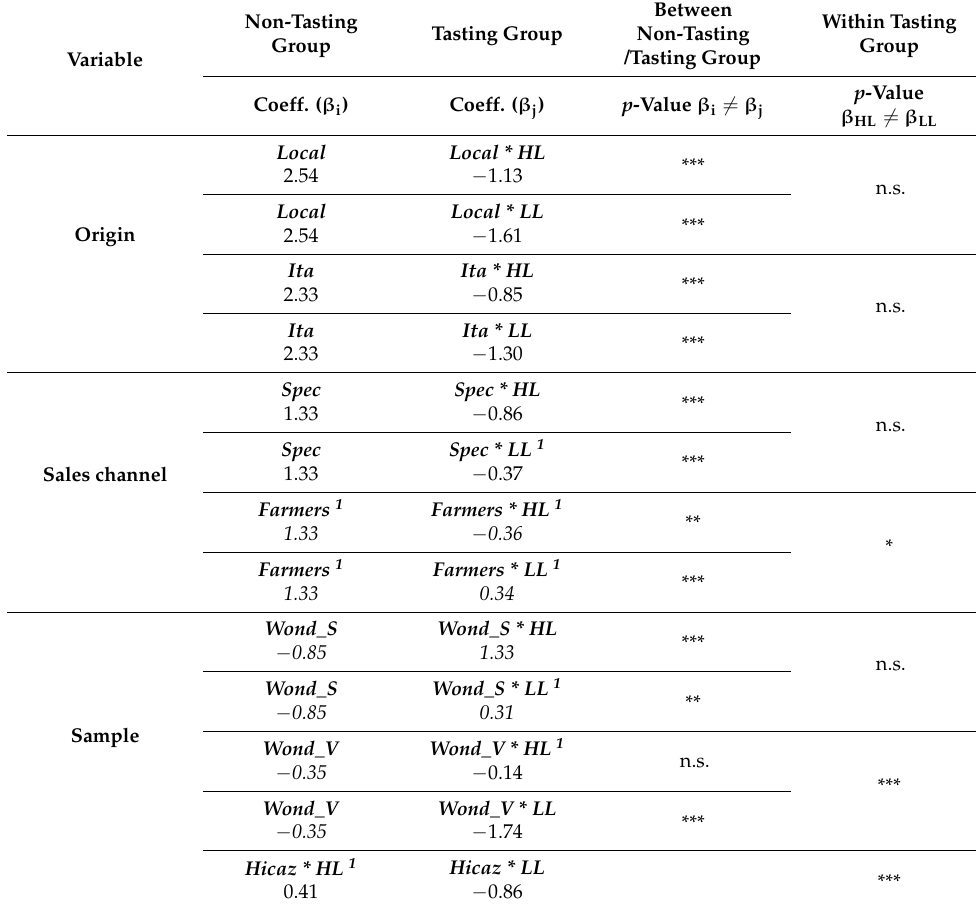
Table 6. Pair comparison of model